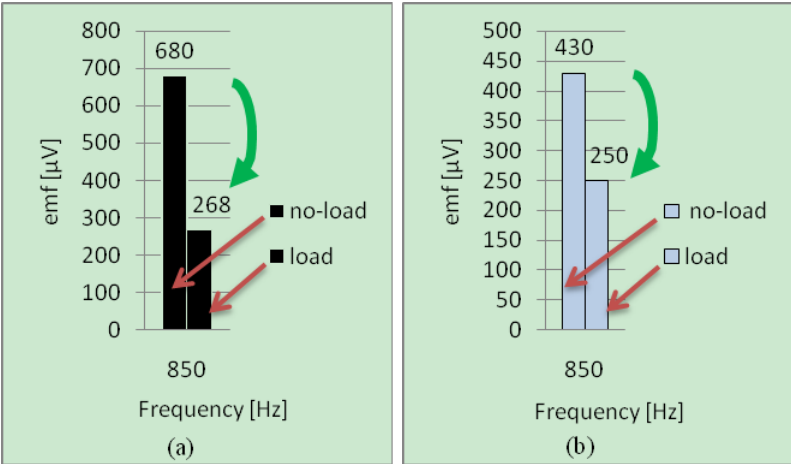
K K   for faulty IM at no-load and sc